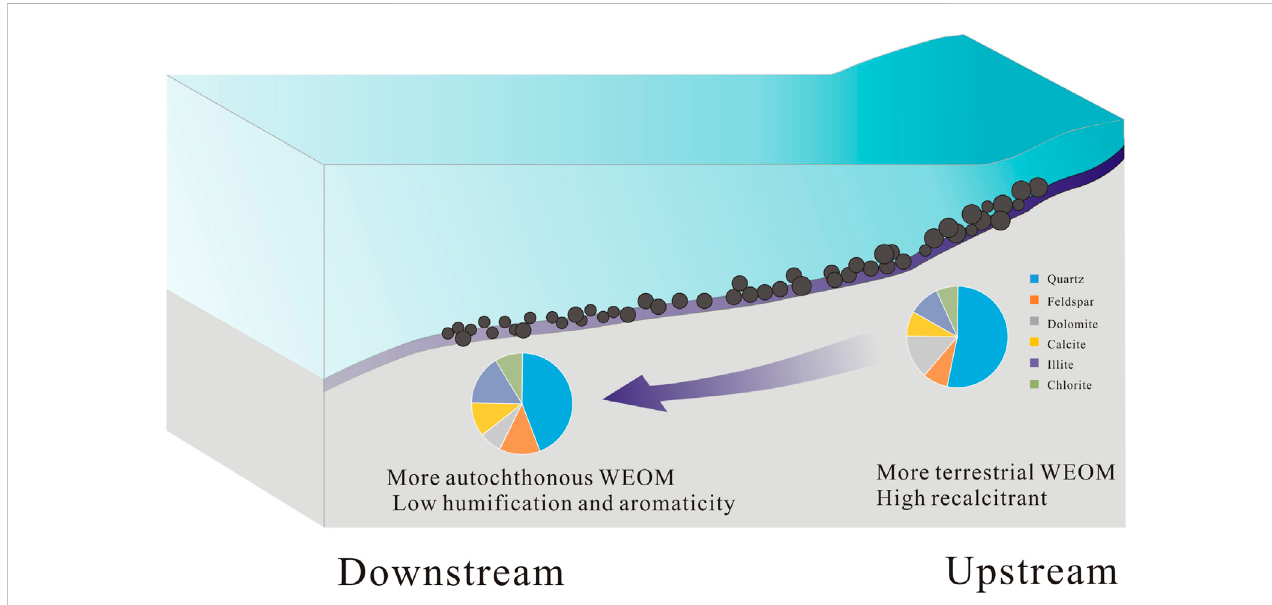
FIGURE 7 Conceptual mode of sediment property-regulated WEOM